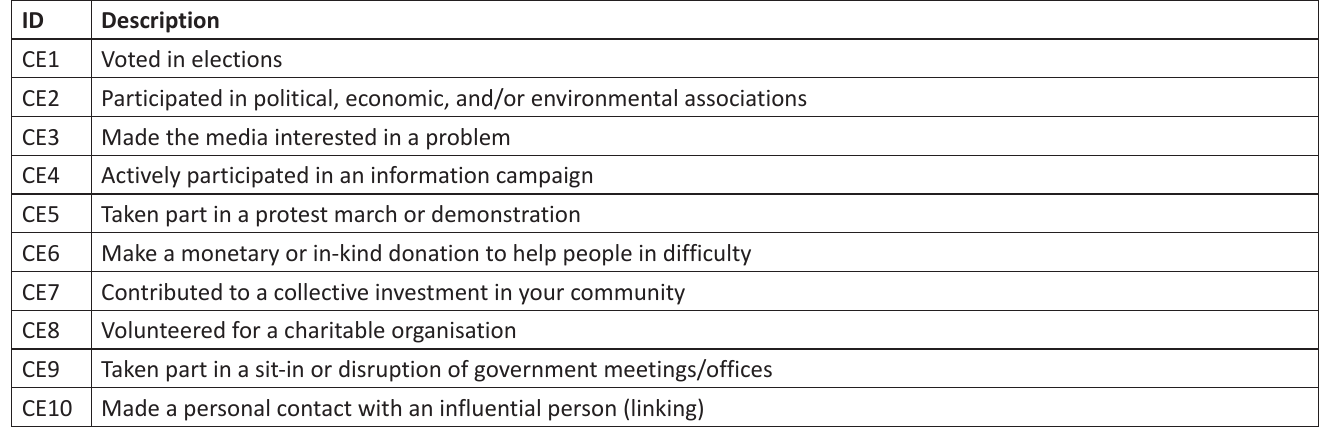
Table 2. Description of Civic Engagement (CE) indicators